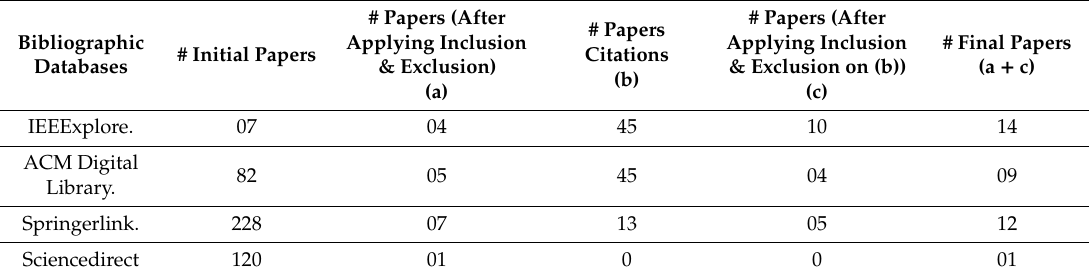
Table 1. Execution of Systematic Mapping